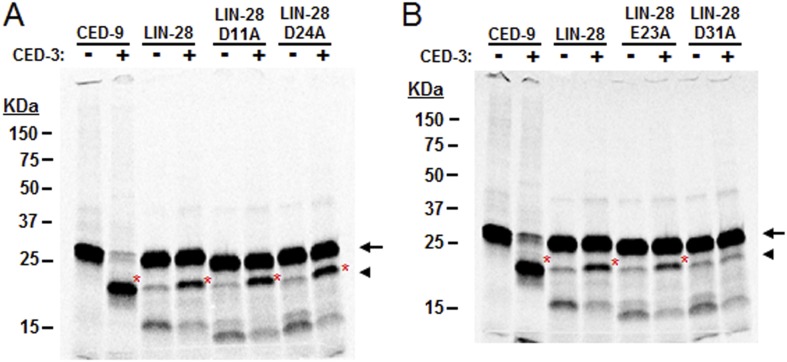
Mutagenesis of LIN-28A to identify the CED-3 cleavage site.Several possible cleavage sites exist in the C. elegans LIN-28A protein corresponding to the tetra-peptide D(E,N,G)xxD(E) cleavage sequence with the alternate residues indicated in parentheses and the proximal residue for cleavage underlined (aspartic acid in this position strongly favored) (Xue et al., 1996). (A–B) Mutants were made for the second acidic residue in the tetra-peptide sequence for all such sites in the LIN-28A N-terminal region but only the DVVD to DVVA mutation (noted as D31A in panel B and Figure 7D) abolished CED-3 cleavage. Cleavage products are indicated by red asterisk. These experiments were run independently of those shown in Figure 7 and thus constitute replicates for the mutant D31A cleavage assay.